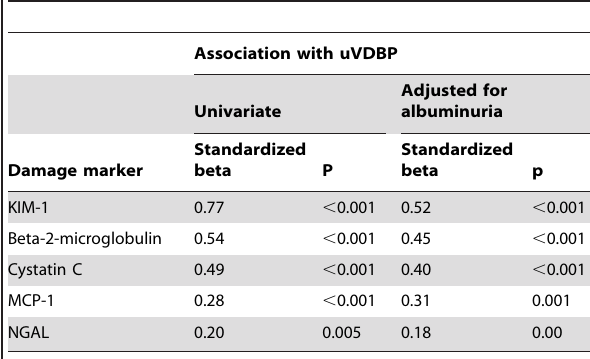
Table 4. Associations of VDBP with renal damage markers across the clinical